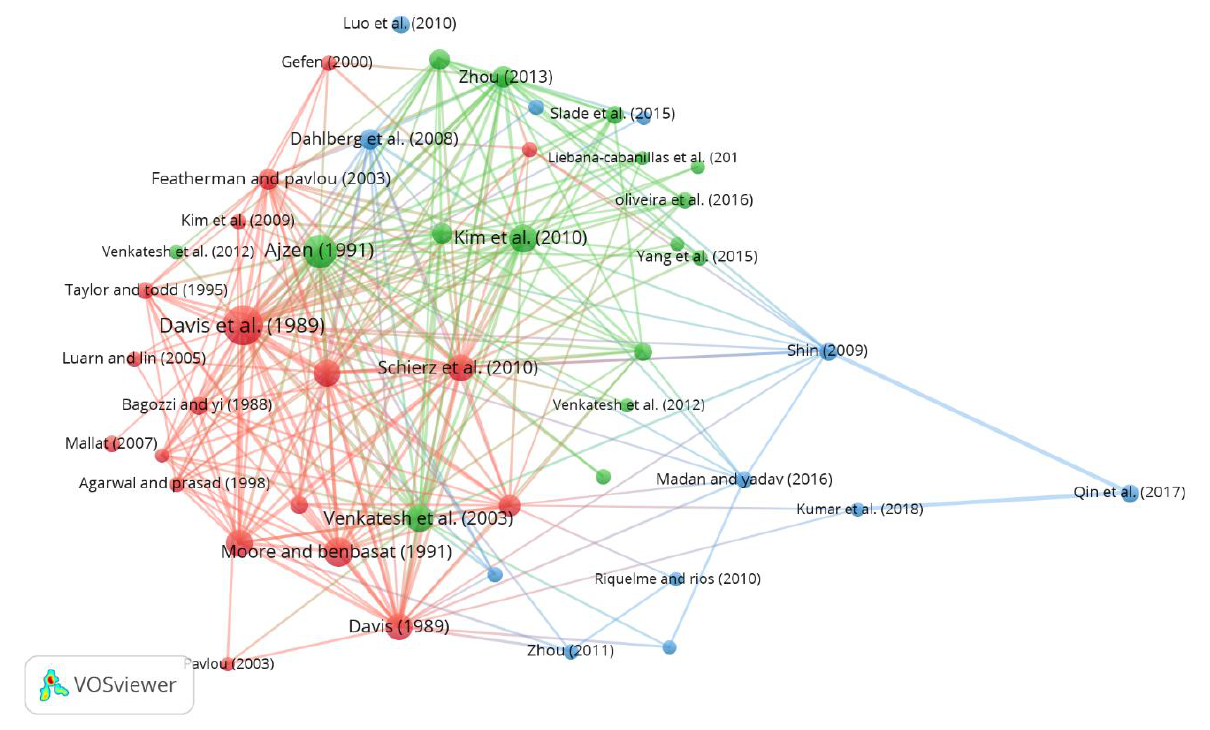
Figure 5. The co-citation network analysis.